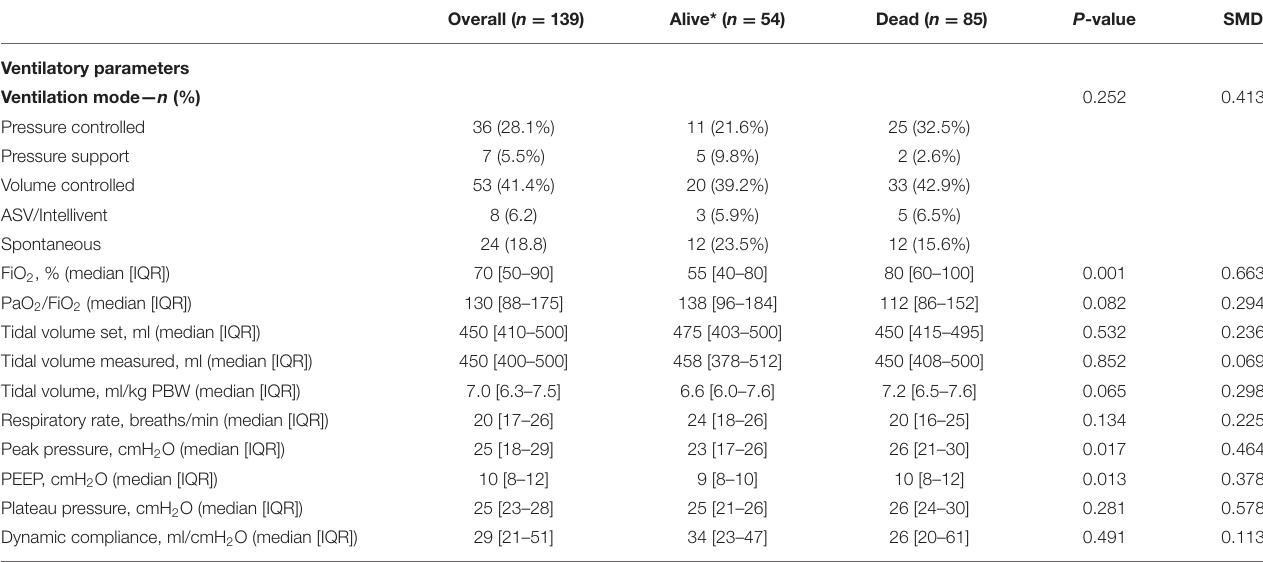
TABLE 2 | Ventilation parameters measured with the baseline chest